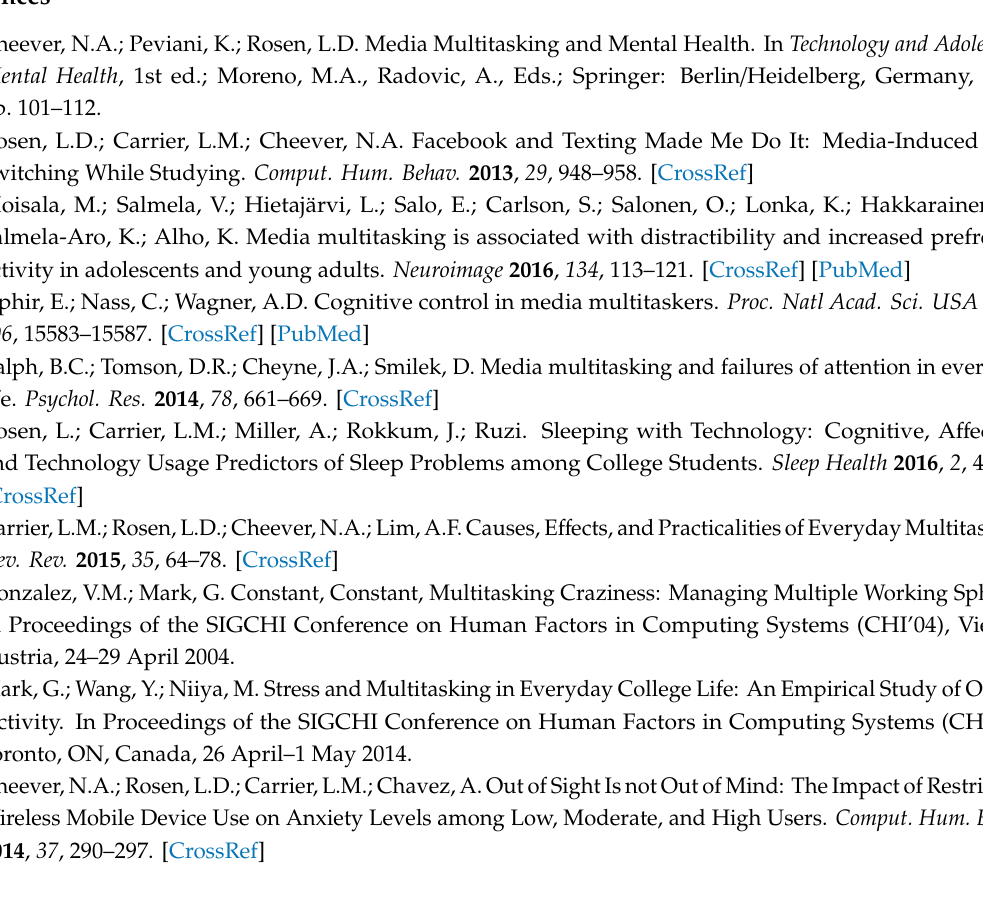
Figure A3. Visual oddball tasks.